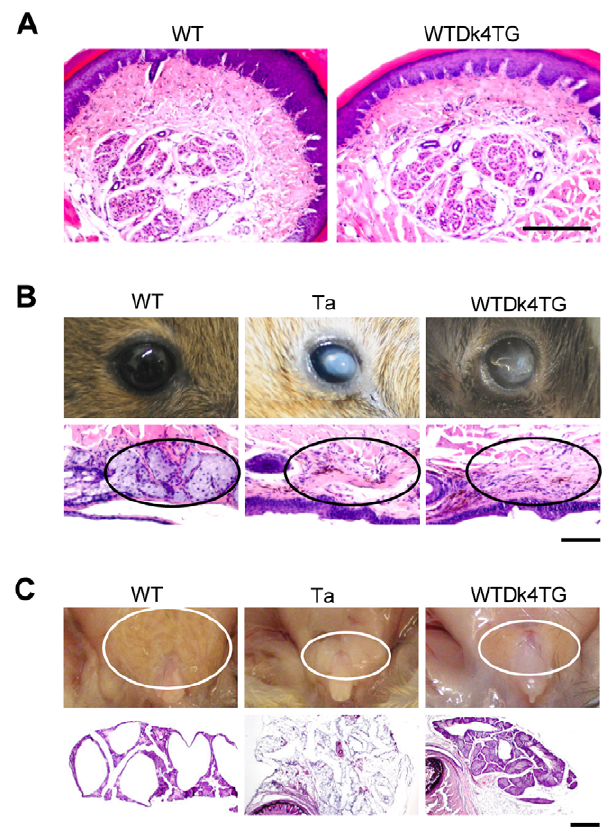
Figure 3. Skin exocrine gland formation was selectively regulated by Dkk4. A, H&E staining shows normally formed sweat glands in adult stage Dkk4 transgenic footpads, which are indistin- guishable from wild-type controls. Scale bar, 200 m m. B, Dkk4 transgenic mice develop cataracts detectable at around 6 months old (upper panels). Like Tabby, Dkk4 transgenic mice lack meibomian glands (lower panels). Scale bar, 100 m m. C, Preputial glands in Dkk4 transgenic mice were about 1/3 of WT control in size (upper panels). Histological analyses showed matured glandular tissue in wild-type mice, absence of glandular tissue in Tabby and smaller, less developed glandular tissue in Dkk4 transgenic mice (lower panels). Scale bar, 500 m m.